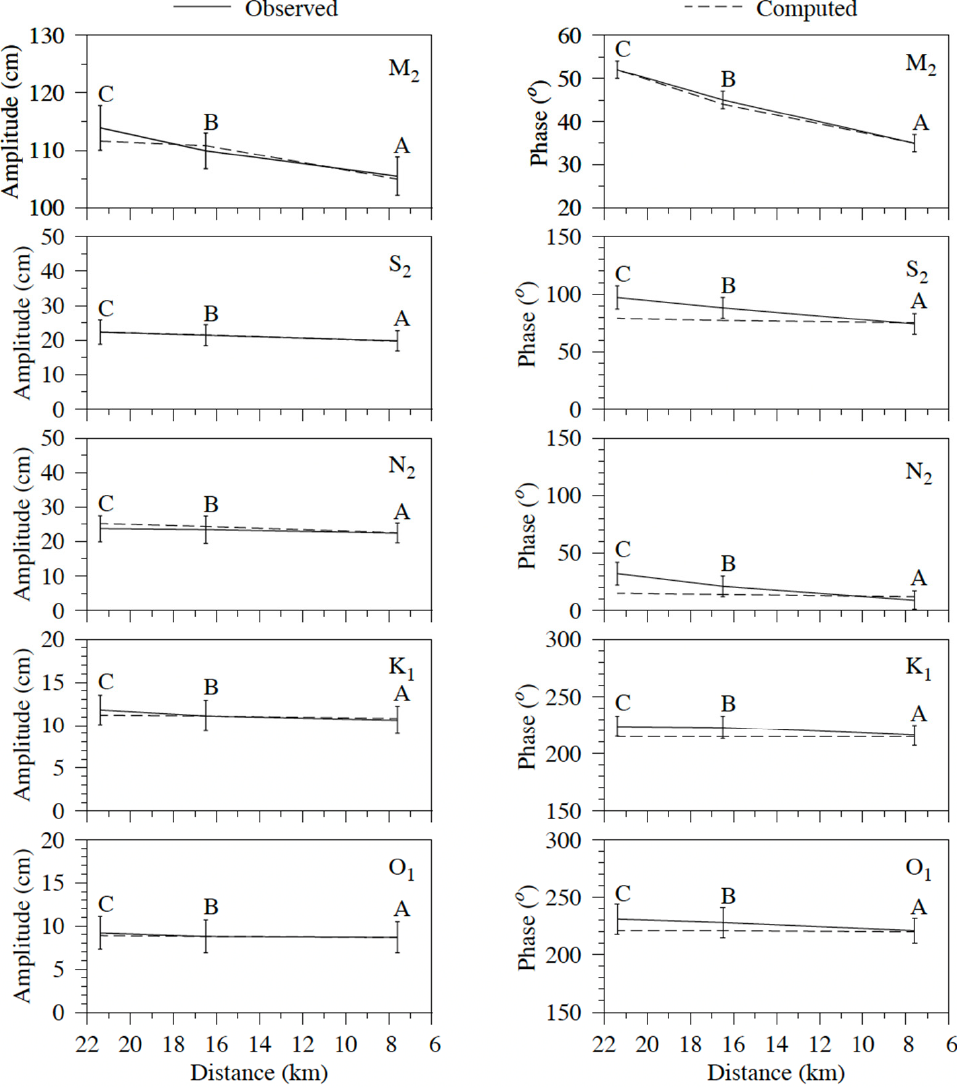
Figure 4. Comparison between model-computed and observed amplitudes and phases of the M 2 , S 2 , N 2 , K 1 , and O 1 tidal elevations at measurement sites A, B, and C. The distance is measured along the mid-axis line starting from the mouth of the Colleton River.